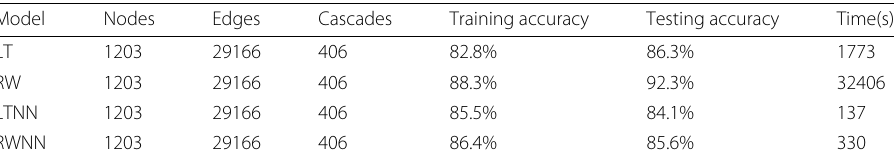
Table 3 Performance of real data